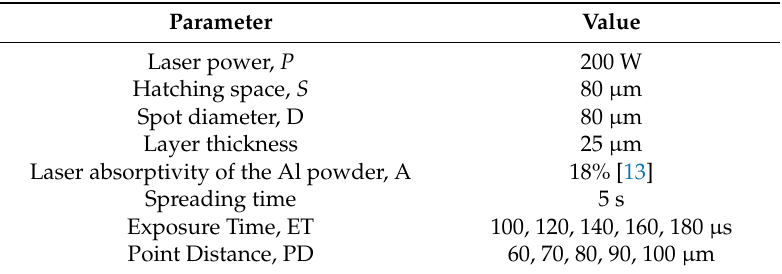
Table 1. The process parameters in simulation and